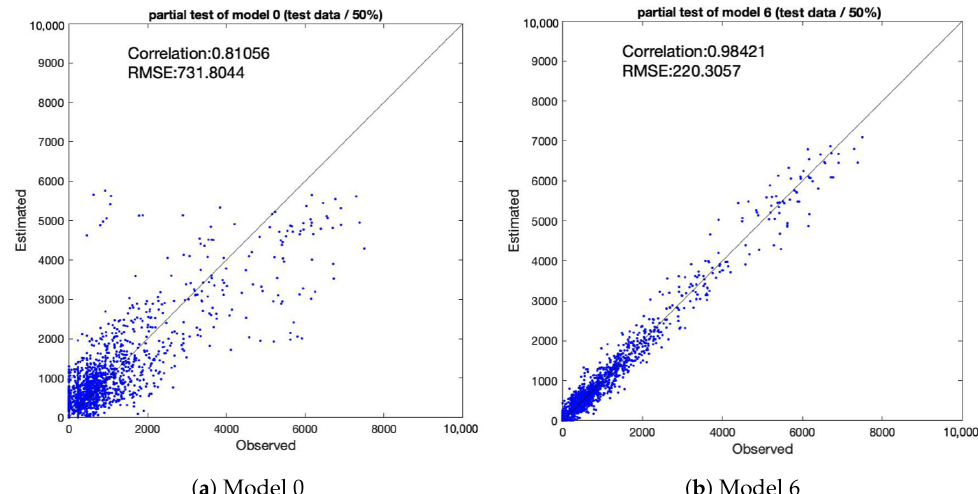
Figure 9. Correlation between observed and estimated population (before event opening).